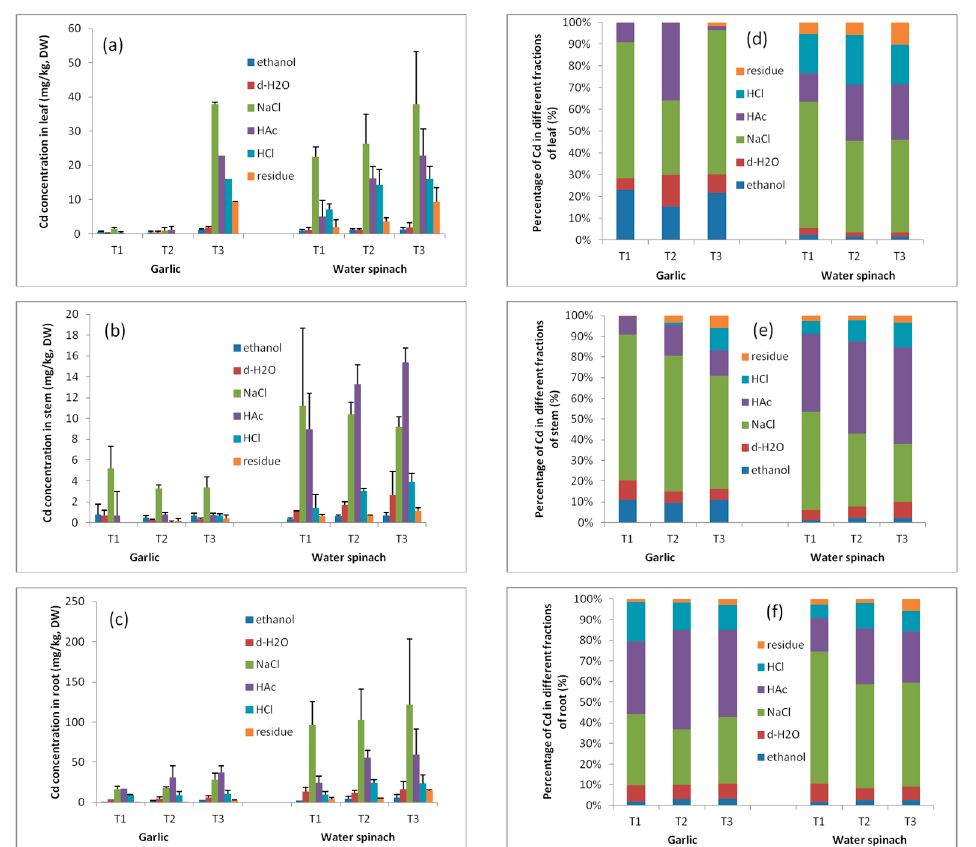
Figure 8. Concentrations and proportions of Cd associated with different chemical forms (extracted by 80% ethanol, d-H 2 O, 1M NaCl, 2% HAc, 0.6 M HCl, and residue) in different tissues (( a ) and ( d ): leaf; ( b ) and ( e ): stem; ( c ) and ( f ): root) of in garlic and water spinach at three time stages (T1-10 d, T2-20 d, T3-30 d) ( n = 3, DW).